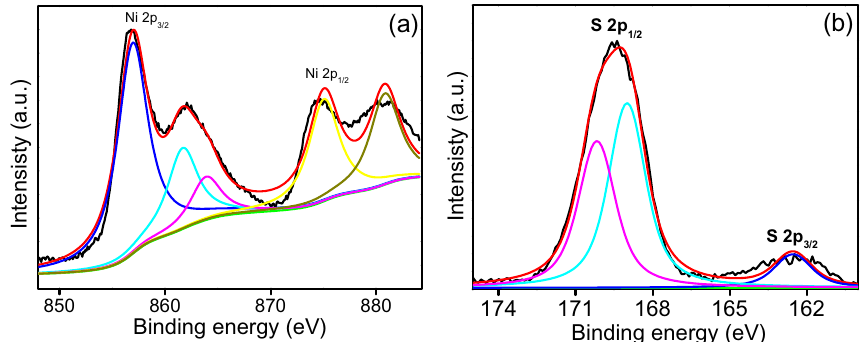
Figure 4. High-resolution XPS spectra of ( a ) Ni 2p and ( b ) S 2p of the SS-NiS@3DNF-E-3 electrode.